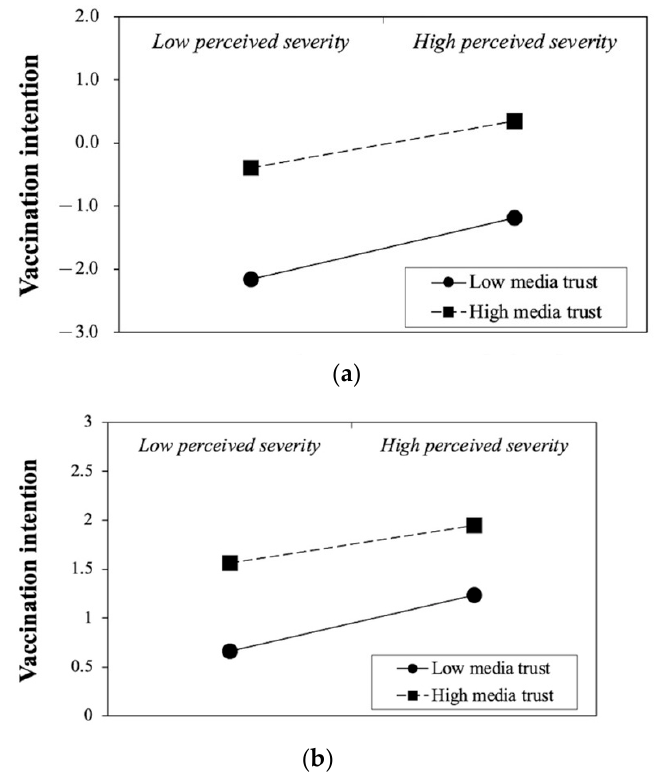
Figure 3. ( a ) Moderating effect of media trust in Mainland China. ( b ) Moderating effect of media trust in Taiwan.